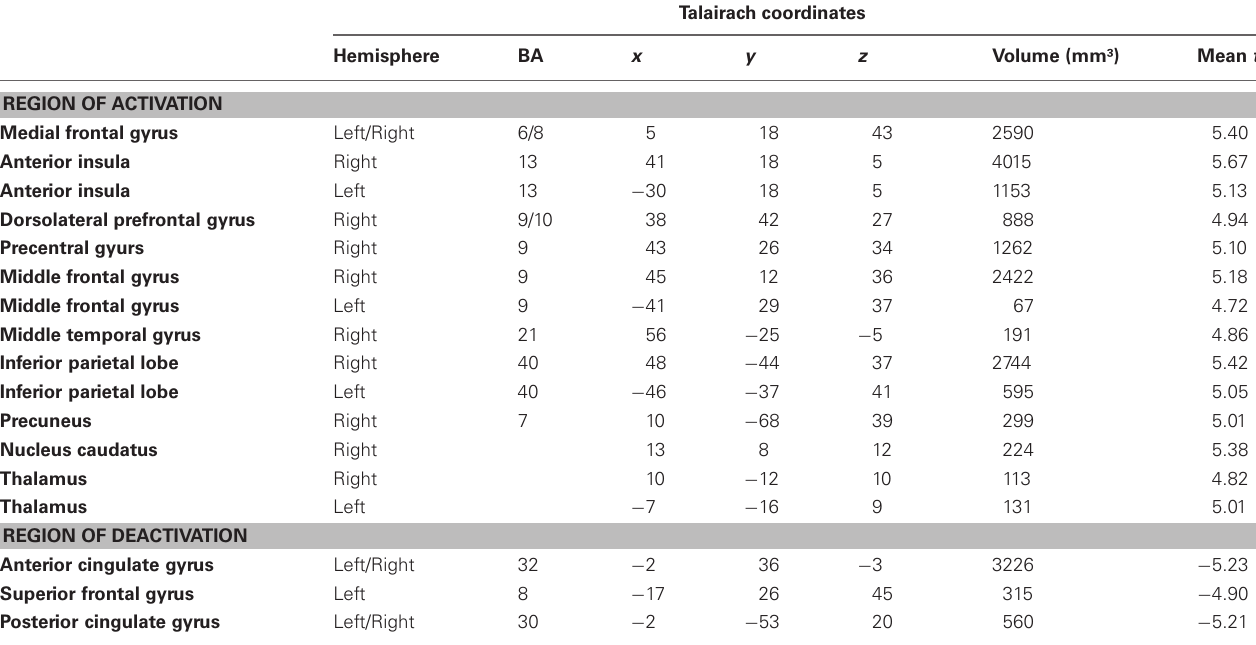
Table 4 | Brain areas with stronger BOLD signal during delayed and omitted feedback compared to the immediate feedback condition ( q = 0 .